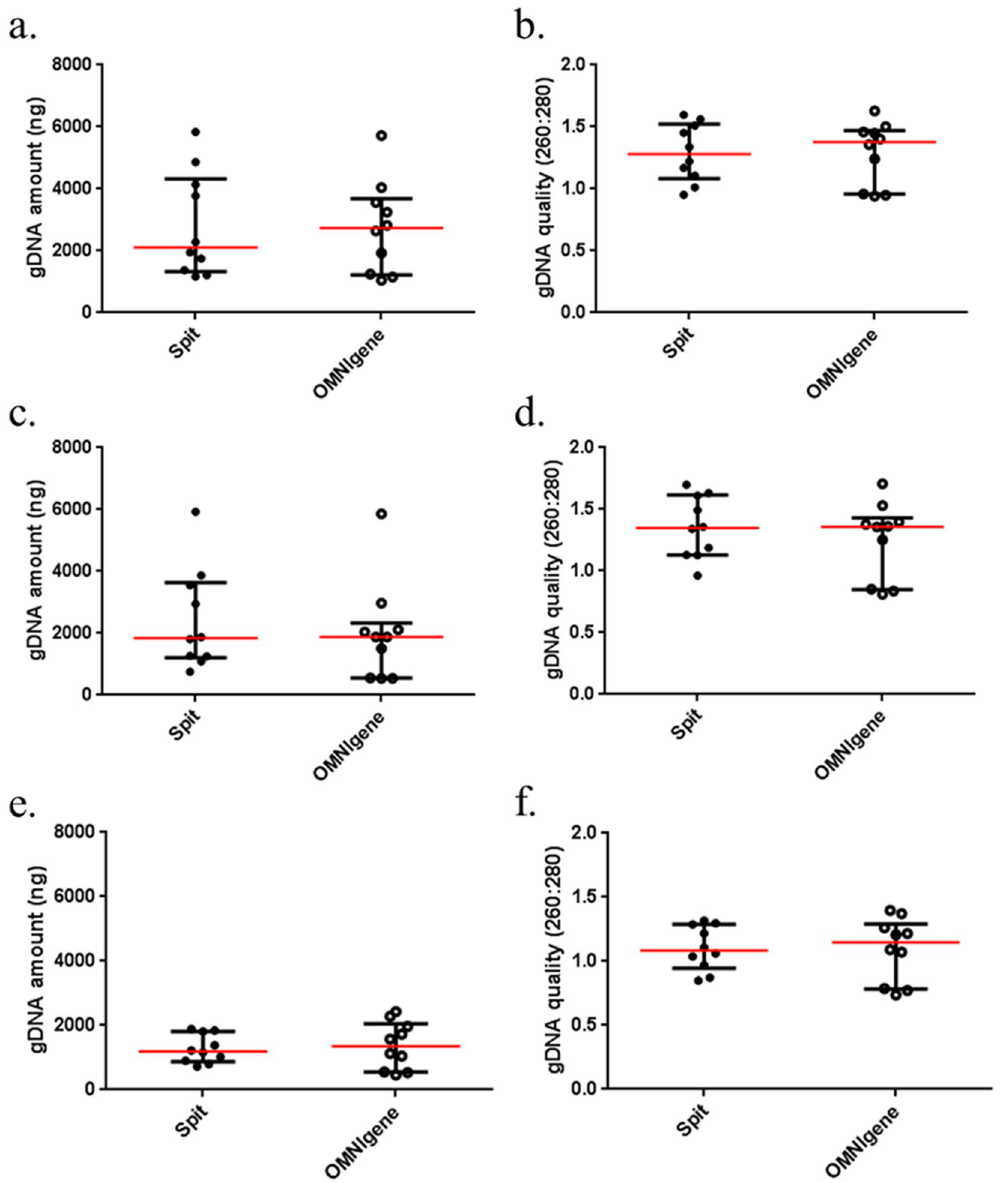
Figure 2. Extracted salivary gDNA from different saliva collection methods. Scatter plots for the average quantity and quality of the extracted gDNA triplicates from each collection and extraction method (a., b. Maxwell ® 16 LEV blood DNA kit; c., d. in-house phenol-chloroform extraction and e., f. QIAamp DNA Microbiome